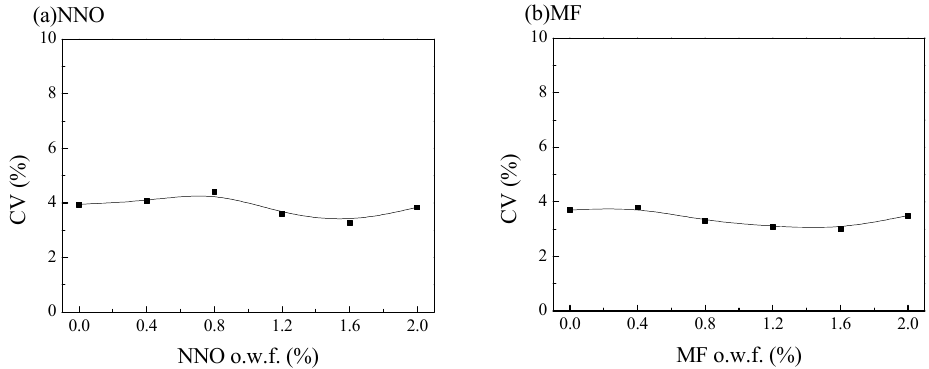
Figure 3. Influence of dispersant NNO ( a ) and MF ( b ) on the dyeing levelness (CV value) of the dyed fabric.